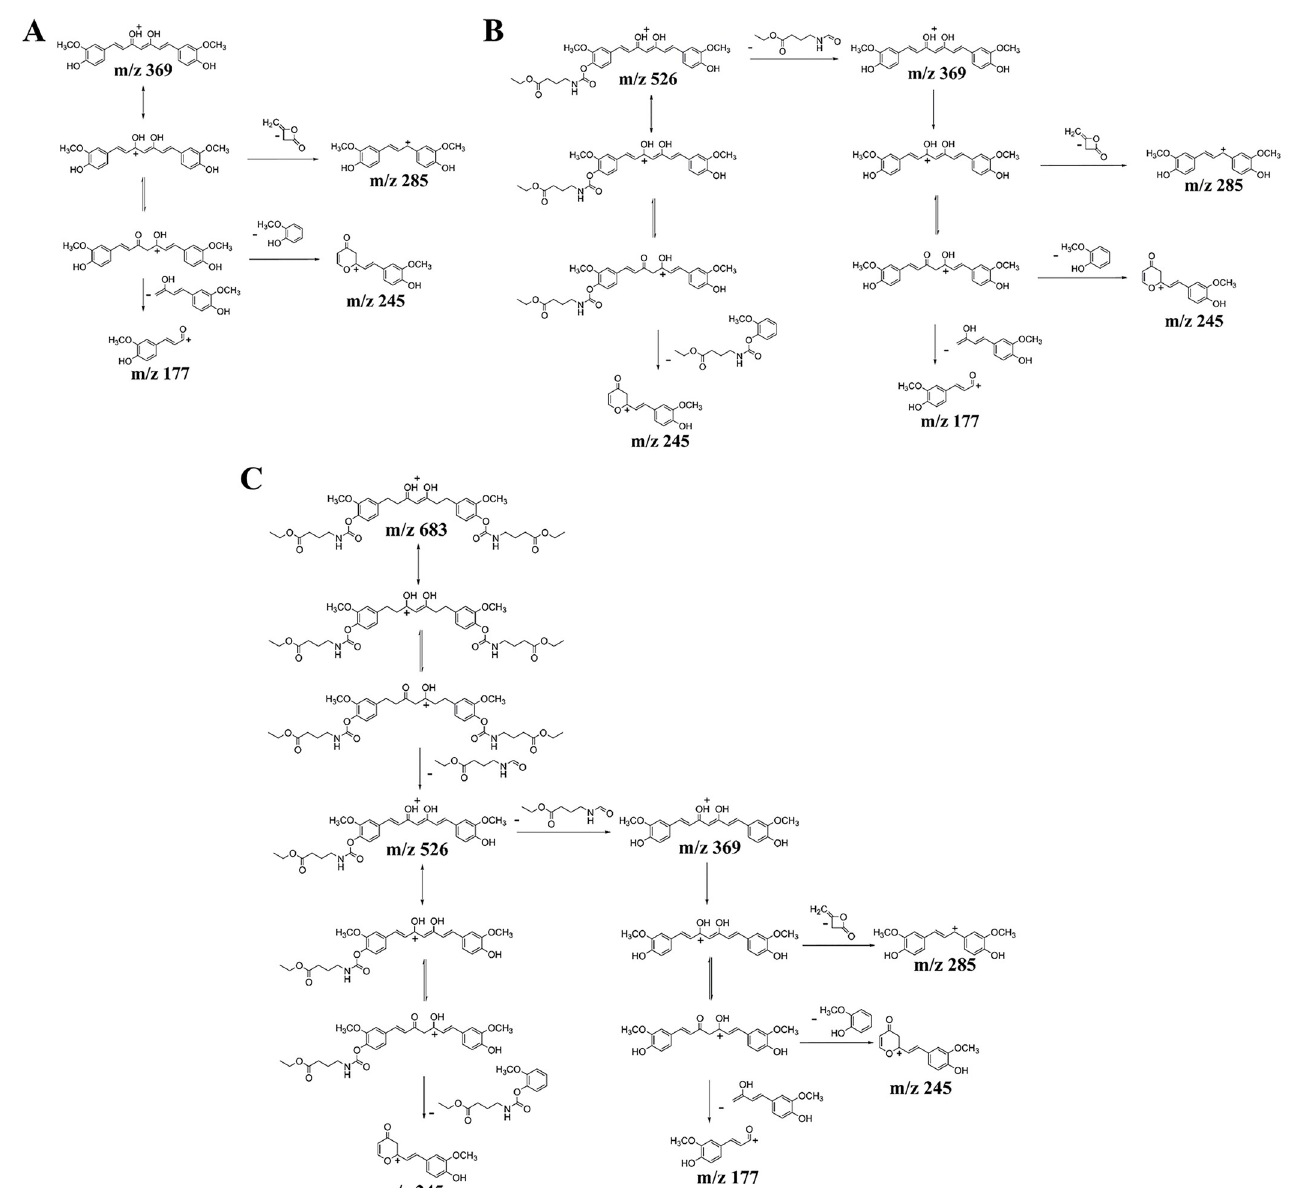
Fig 7. Proposed mass fragmentations of (A) curcumin, (B) CUR-1GE and (C) CUR-2GE.